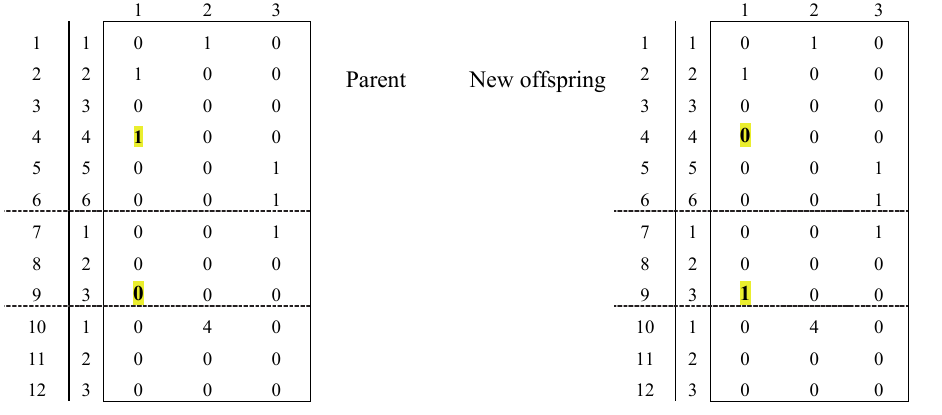
Fig. 4. An example of the mutation-flipping operator